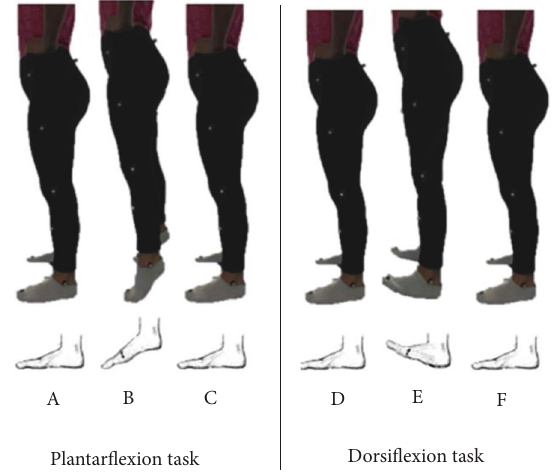
Figure 2: Pictorial description of the plantar fl exion (PF) and dorsi fl exion (DF) tasks showing (a) loaded phase (foot fl at), (b) unloaded phase (during PF), (c) reloading of the heel (foot fl at), (d) loaded phase (foot fl at), (e) unloaded phase (during DF), and (f) reloaded phase (foot fl at). Note both tasks were performed as two independent sessions and were